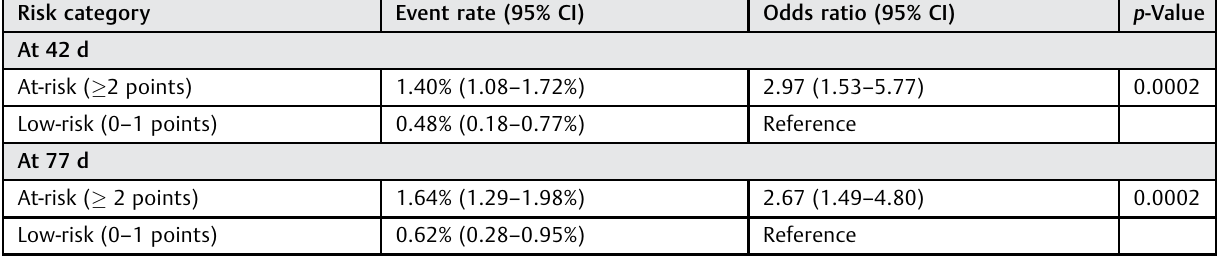
Table 7 Risk strati fi cation by the IMPROVEDD VTE risk category Risk category